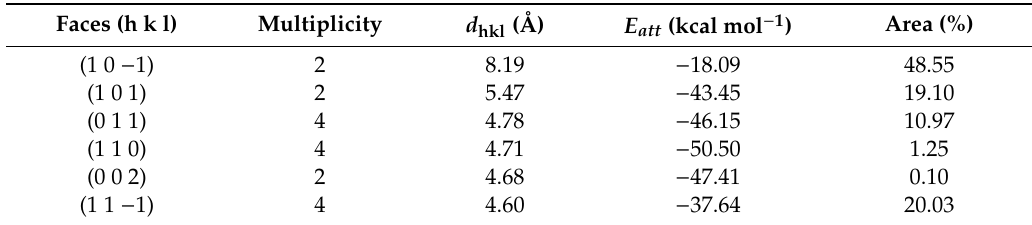
Figure 3. The predicted catechol crystal morphology in the vacuum ( a ) and the intermolecular interactions in the catechol unit cell calculated by the Crystal Graph ( b ). Table 2. The parameters of the catechol crystal faces in the vacuum predicted via the attachment energy (AE) model.